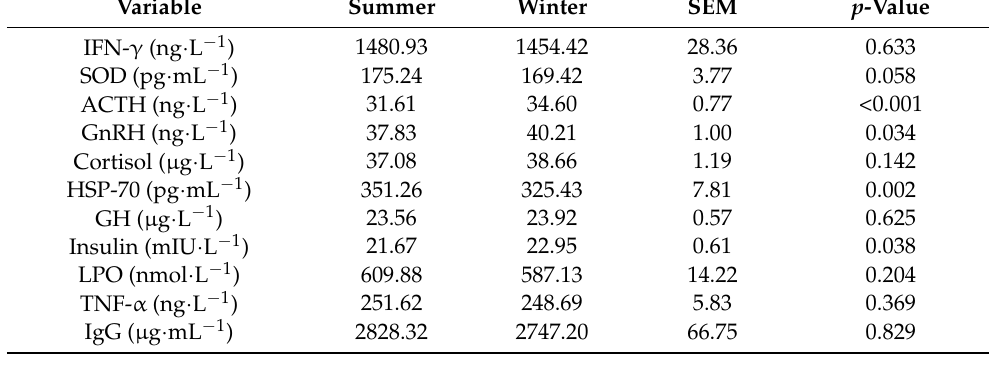
Table 4. Plasma metabolism and endocrine concentrations of calves before weaning in summer and winter.